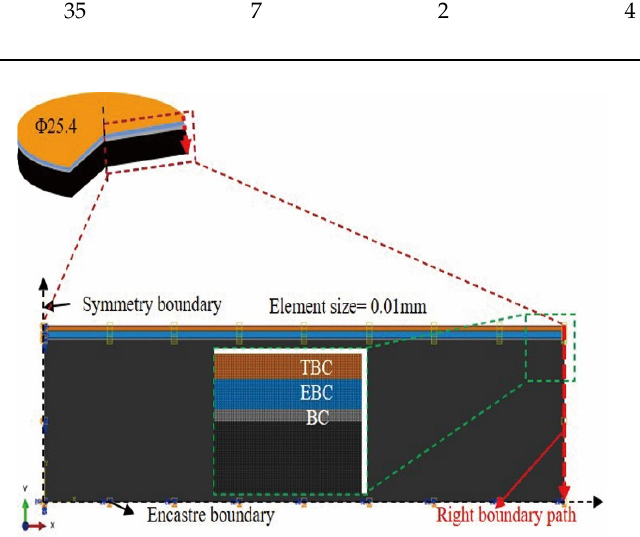
Figure 3. Finite element model for T/EBCs coating system.